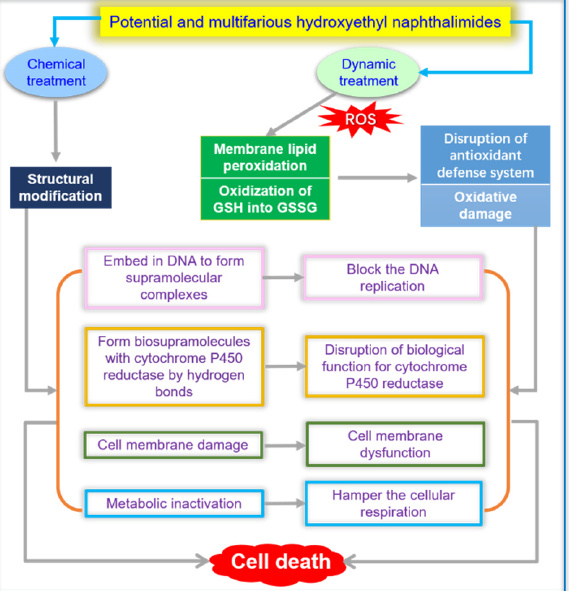
Figure 10. Schematic showing proposed mechanism of hydroxyethyl naphthalimides with synergistic potential of chemical and dynamic antifungal treatment.